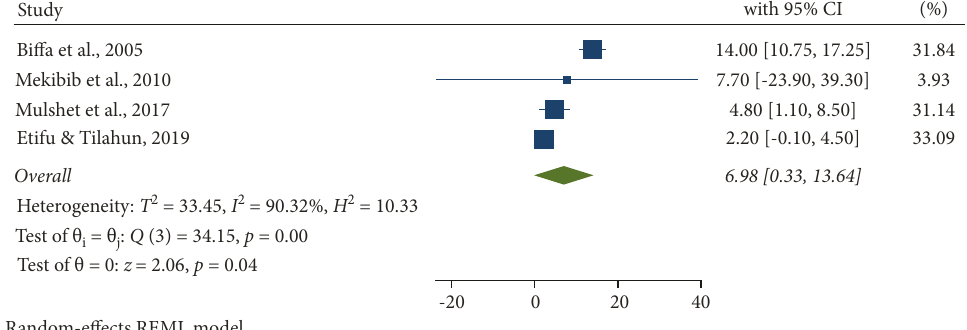
Figure 14: Teat injury as an associated risk factor for mastitis among dairy cows.